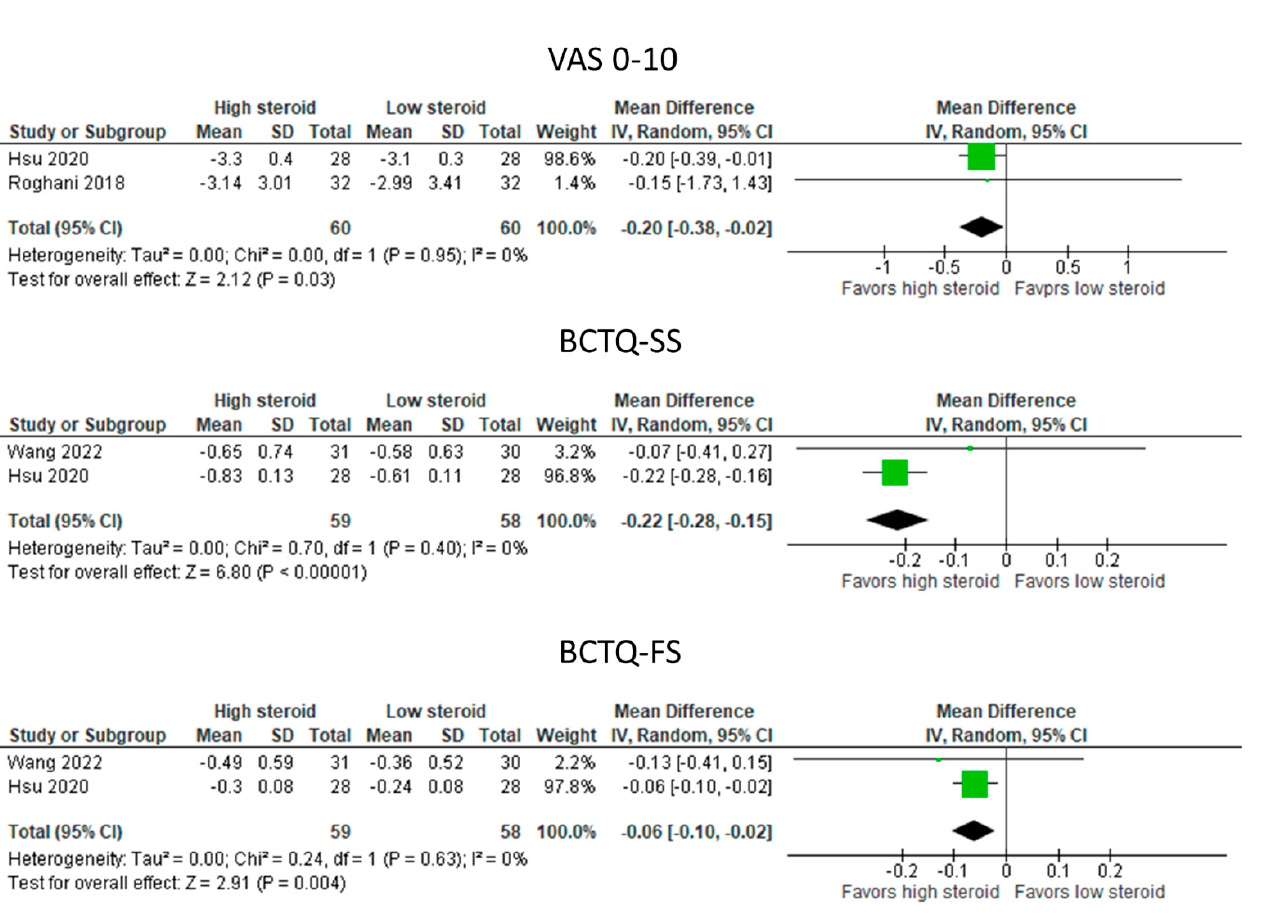
Figure 3. Meta—analysis of UPIT with high—dose vs. low—dose steroids. VAS, visual analogue scale; BCTQ—SS, Boston Carpal Tunnel Questionnaire—symptom scale; BCTQ—FS, Boston Carpal Tunnel Questionnaire—functional scale. The green squares represent the differences between the means of each of the two groups compared, i.e., the mean differences. The size of the green square represents how much that individual study affects the overall outcome of the meta—analysis, i.e.